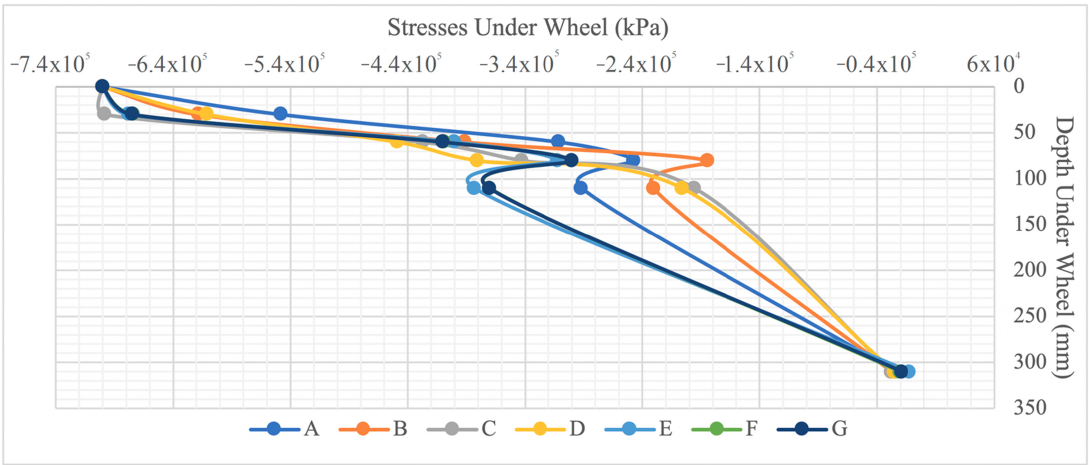
Figure 6. Surface vertical displacement effect due to geo-grid position.